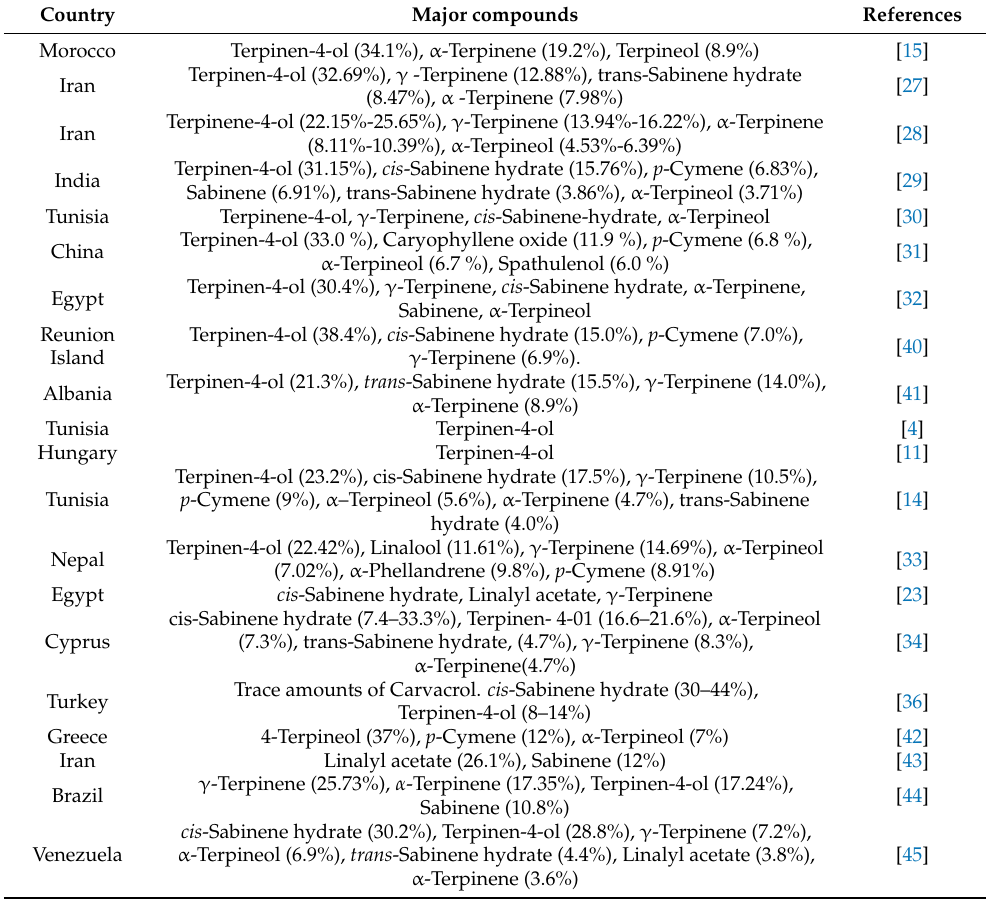
Table 2. The major chemical compounds in the essential oil of O. majorana in the different countries.